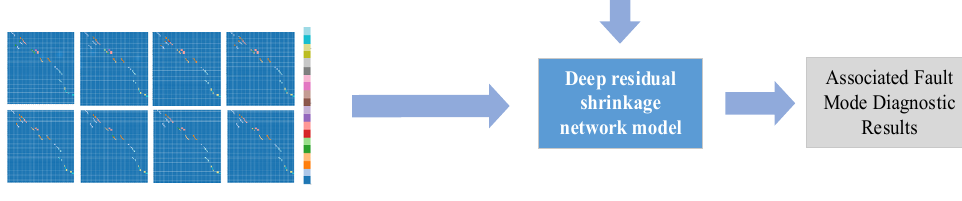
Figure 7. Schematic graph of power supply system associated fault diagnosis model.